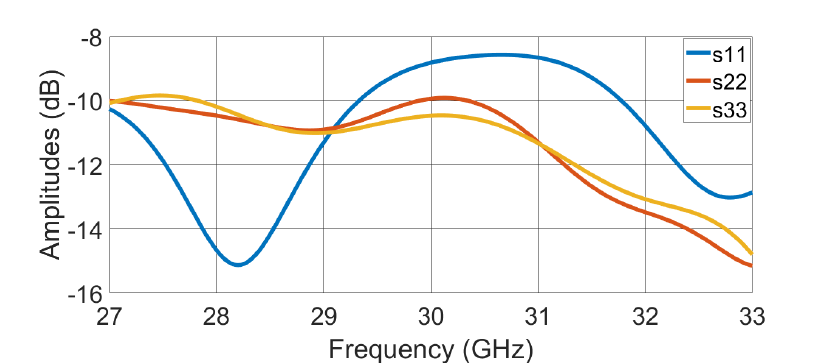
Figure 26. Proposed Rotman lens with absorbers in the side walls reflection coefficients.